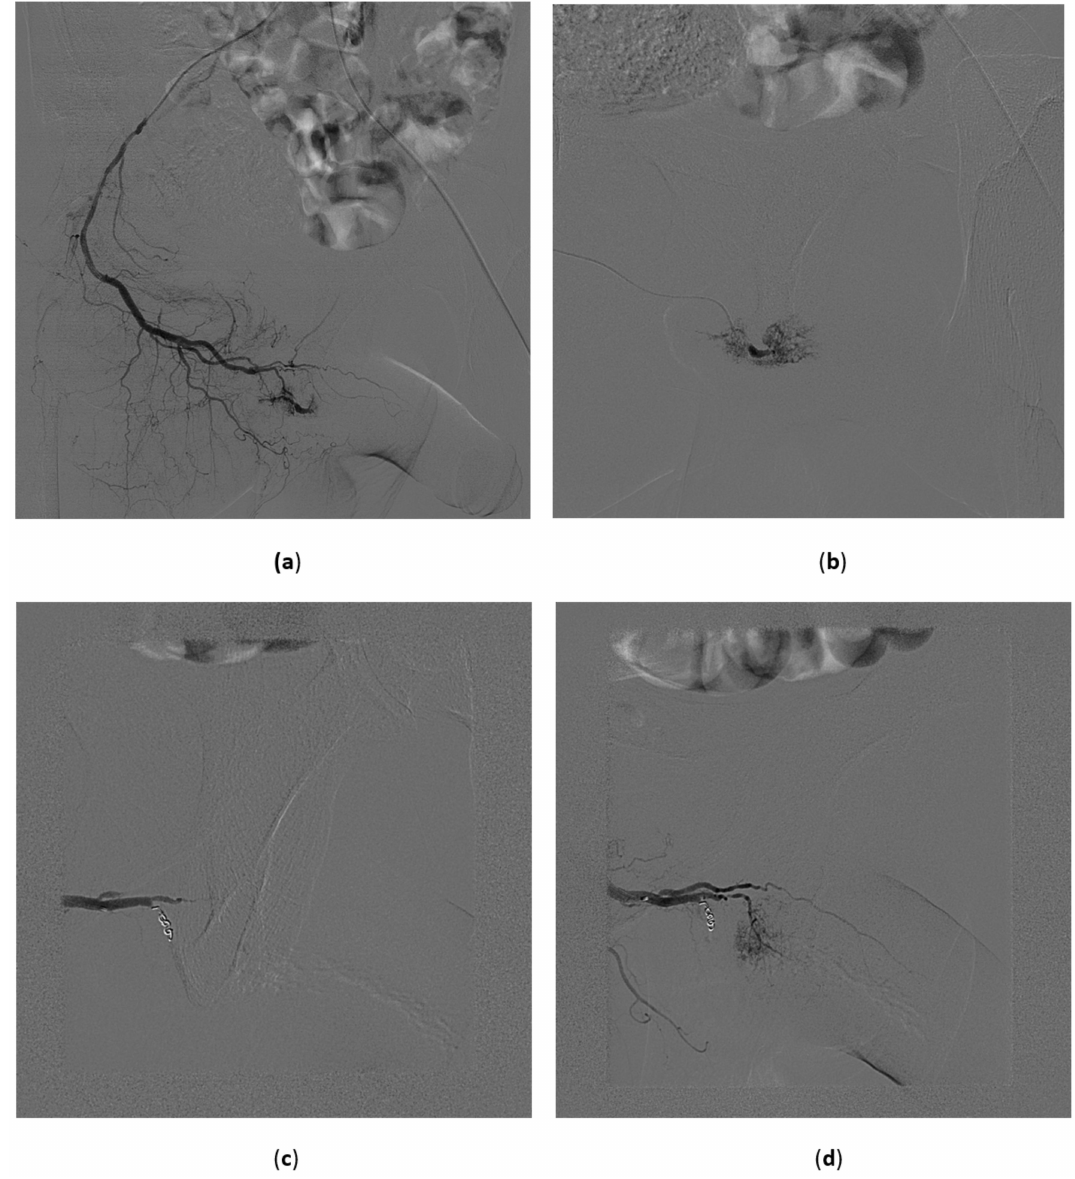
Figure 9. High-flow priapism. 45-year-old male, recent perineal trauma. CDUS reveals an arterocavernous fistula on the right side. ( a ) Selective angiography with injection in the proximal pudendal artery shows the cavernosal fistula at the basis of the penis; ( b , c ) A microcatheter was advanced with the tip to the site of the fistula and a small microcoil was deployed with complete occlusion of the lesion ( c , d